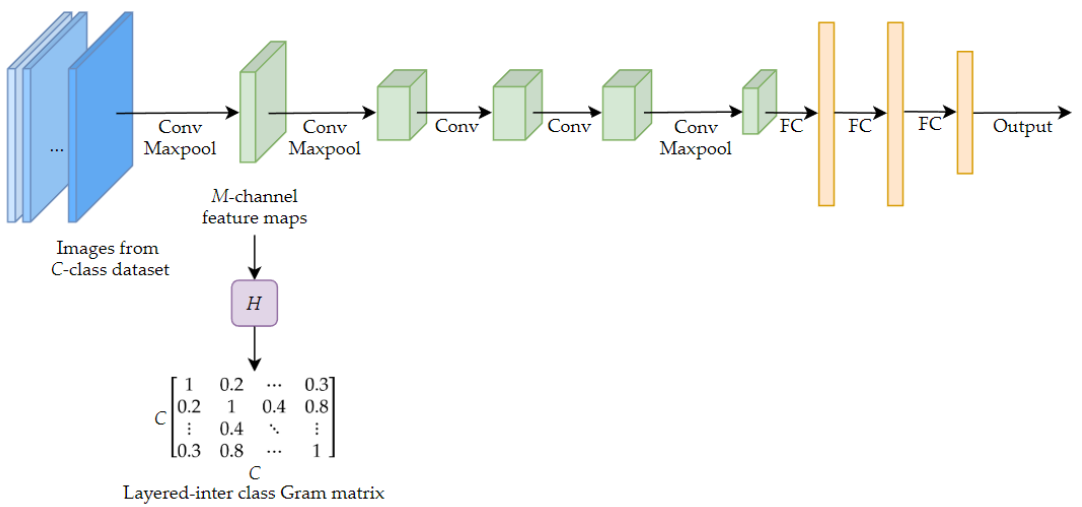
Figure 3. Illustration of the layered inter-class Gram matrix.